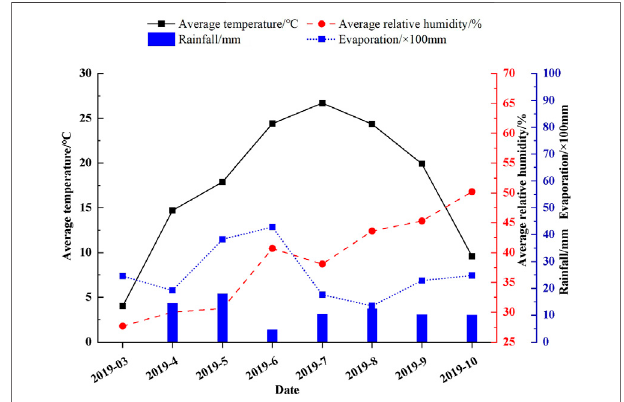
FIGURE 2 | Characteristics of changes in meteorological factors in the pilot area between March and October 2019.